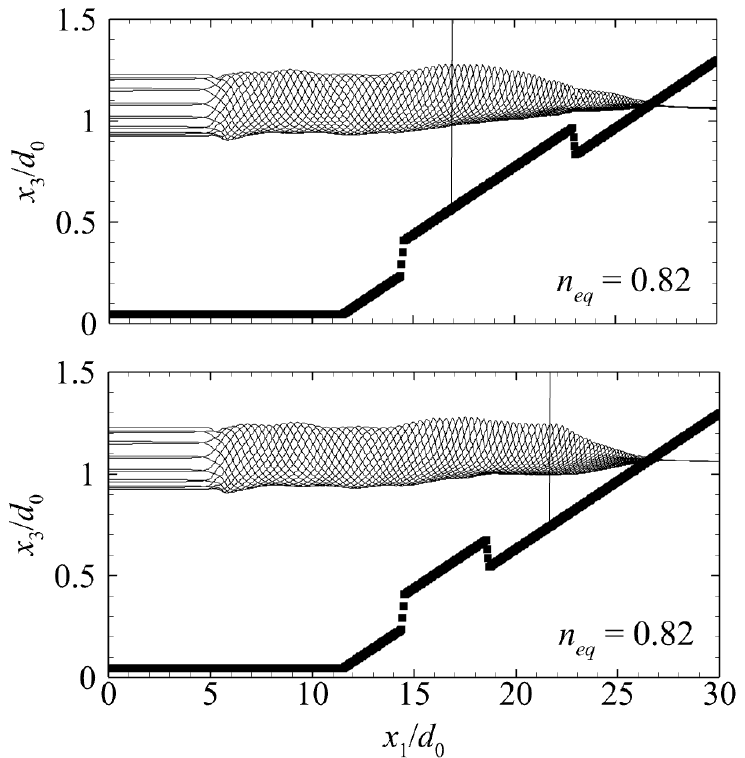
Figure 9. Phase ‐ averaged 2DV envelope of the free ‐ surface elevation of waves propagating and Figure 9. Phase-averaged 2DV envelope of the free-surface elevation of waves propagating and breaking over CV fields with n eq = 0.82 and different L CV (Case 5 ‐ top and Case 6 ‐ bottom). Note that breaking over CV fields with n eq = 0.82 and different L CV (Case 5- top and Case 6- bottom ). Note that the axes are in scale x 1 / x 3 = 0.1 for clarity of the exposition. the axes are in scale x 1 / x 3 = 0.1 for clarity of the exposition.